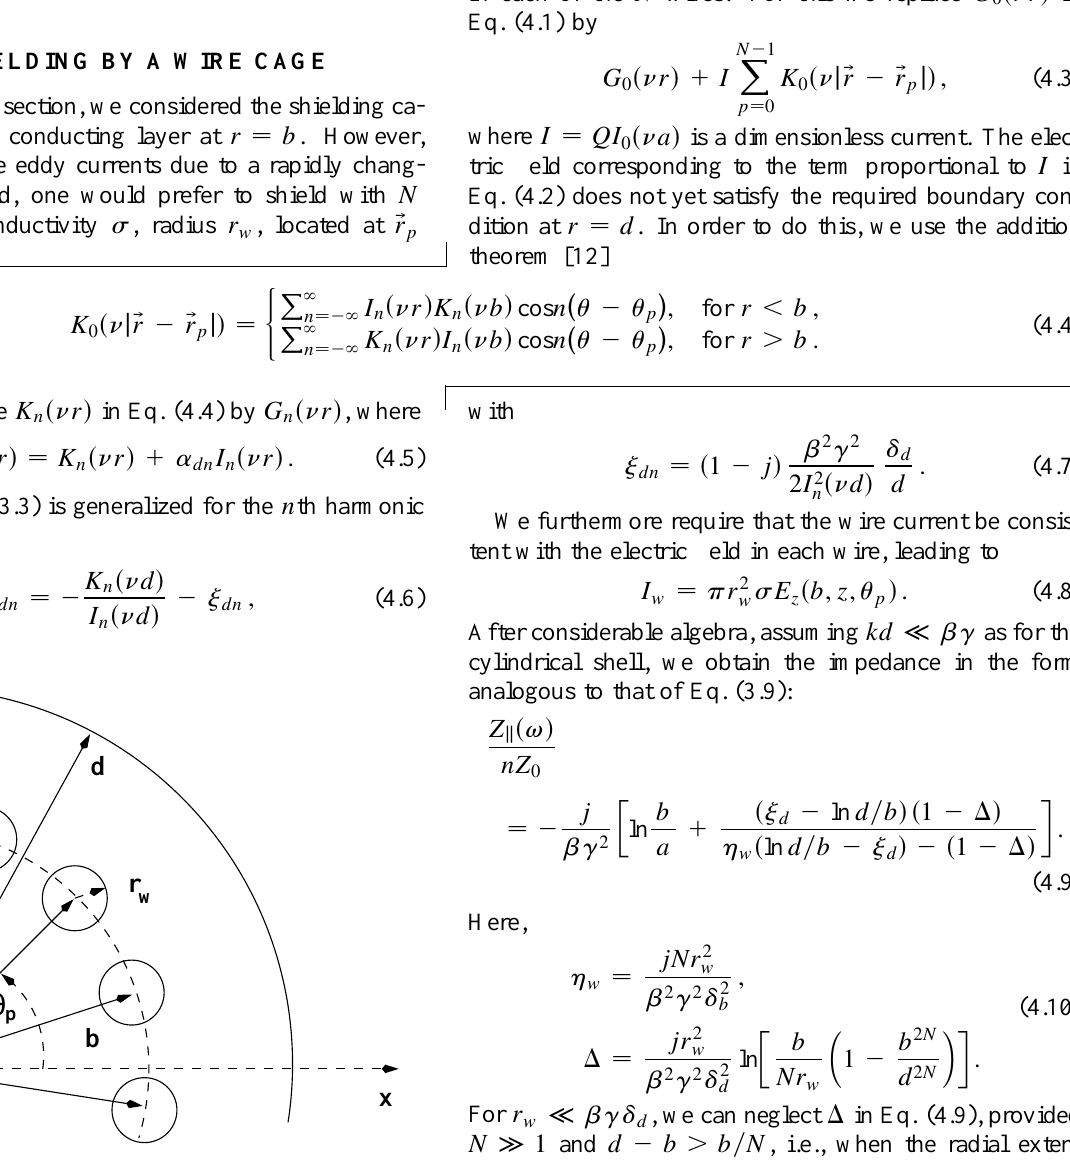
FIG. 3. Geometry of a wire